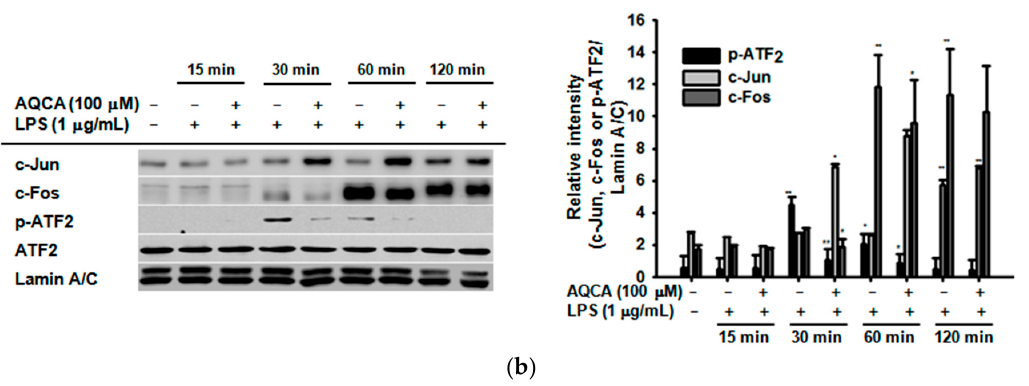
Figure 2. Effect of AQCA on transcriptional activation of the inflammatory response. ( a , b ) nuclear fractions were prepared from LPS-treated RAW264.7 cells and the total protein levels of p50, p60,